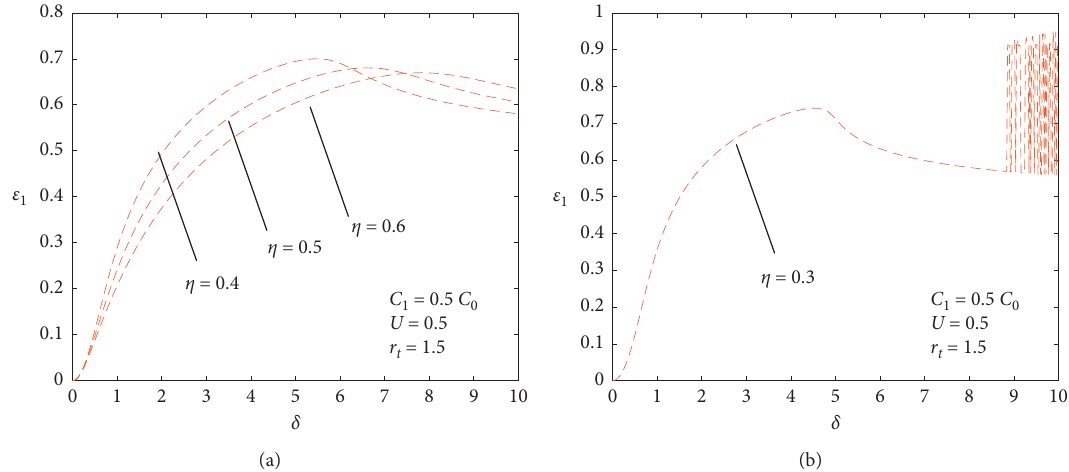
Figure 11: The influence of η on the unbalance response of the rotor-DCSFD system: (a) stability; (b)